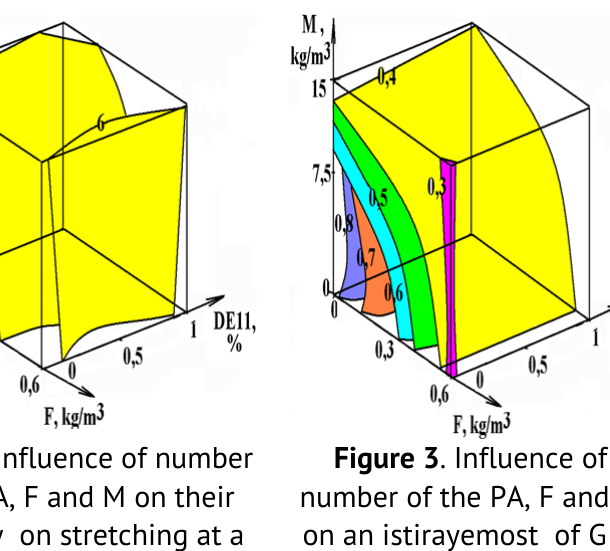
Figure 3 . Influence of number of the РА , F and M on an istirayemost of G (x 10 -3 kg/m 3